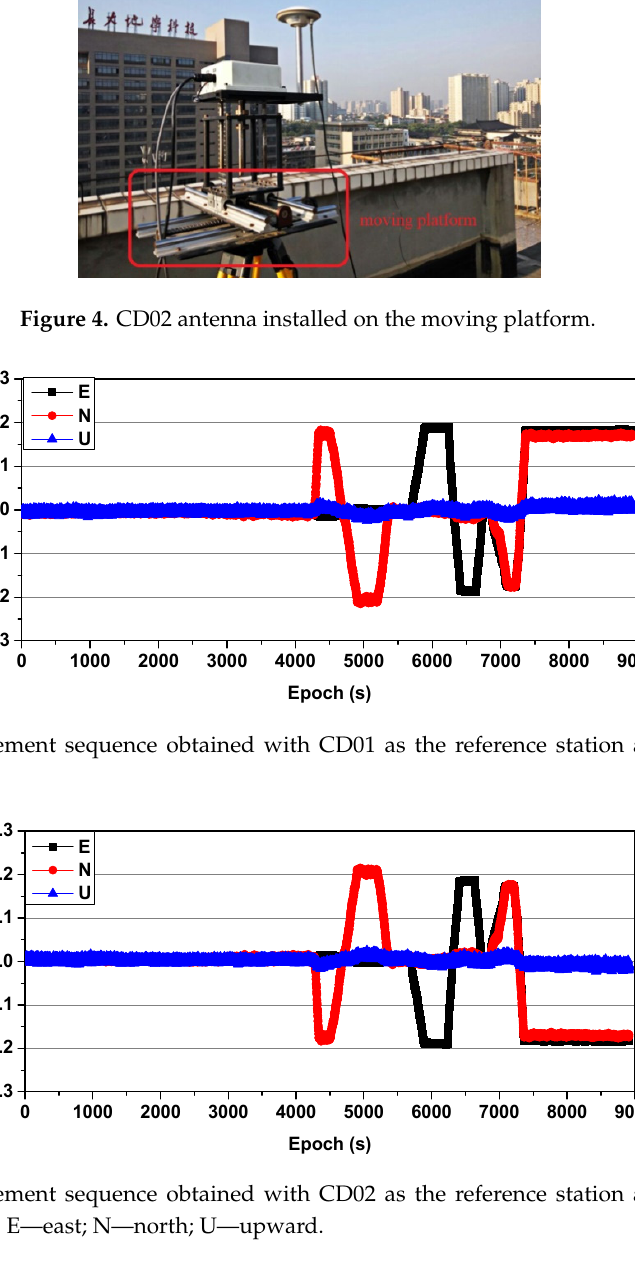
Figure 7. Simulated displacement of the reference station. To simulate the displacement of the reference station in the next experiment, CD02, which was installed on the moving platform, was selected as the reference station, and CD01 as the monitoring station. The positioning results in the N direction were then simultaneously calculated via the SRTK and ARTK methods, as shown in Figure 8. The figure shows that the positioning results obtained via the SRTK and ARTK methods remained in a stable range when reference station CD02 remained stationary. The 3 (cid:3400) 𝜎 (cid:3014)(cid:3020)(cid:3006)((cid:3025) (cid:3250)(cid:3267)(cid:3269)(cid:3260) (cid:2879)(cid:3025) (cid:3268)(cid:3267)(cid:3269)(cid:3260) ) term was calculated according to the methodology in Section 2, and was determined to be equal to 0.035 m , to be used as the threshold for an acceptable difference between positioning results obtained via the STRK and ARTK methods. When the reference station was stationary, the difference between the results obtained for any three consecutive epochs via the two methods did not exceed this threshold. However, when reference station CD02 shifted in the N direction, the difference between the results obtained via the two methods increased significantly, as shown at the end of Figure 8. This part of the plot is enlarged and is shown as Figure 9.